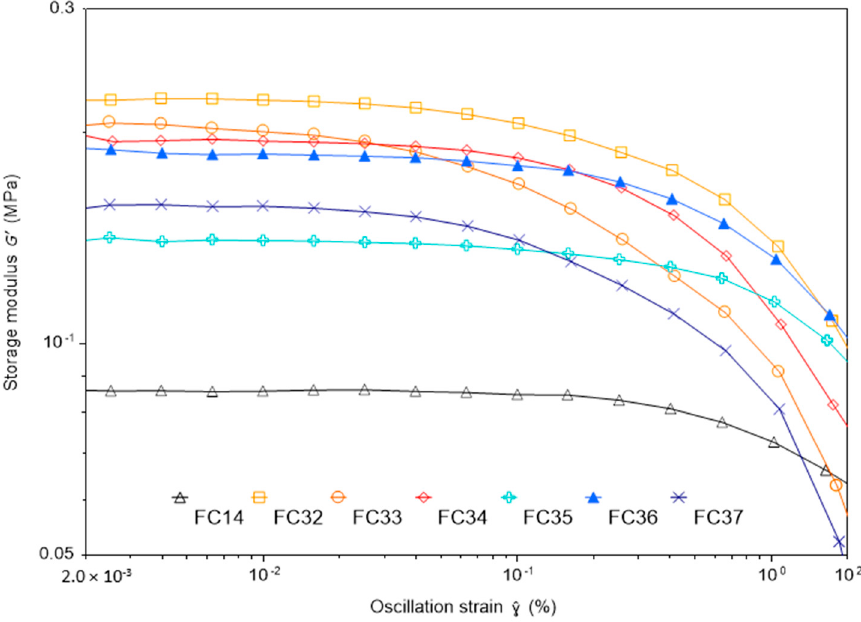
Figure 13. A plot of storage modulus examined for each of the chemically crosslinked